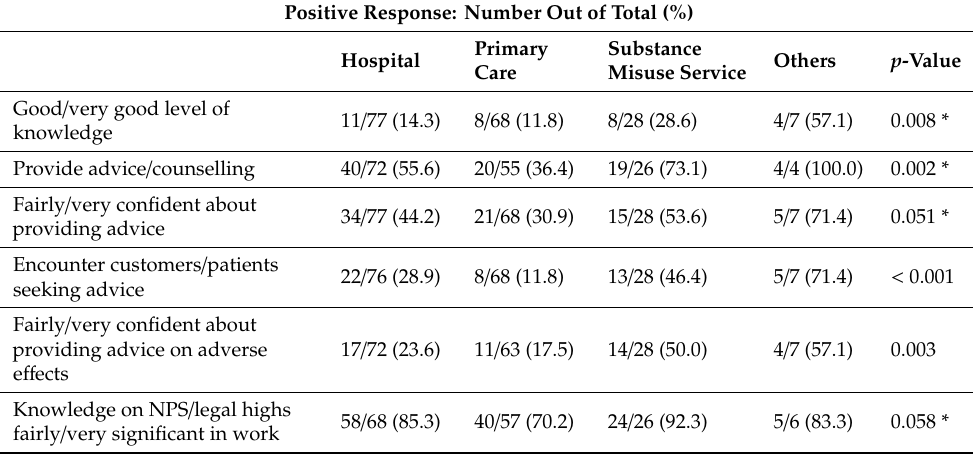
Table 1. Comparison of type of practitioner by aspects of NPS use between health sectors.